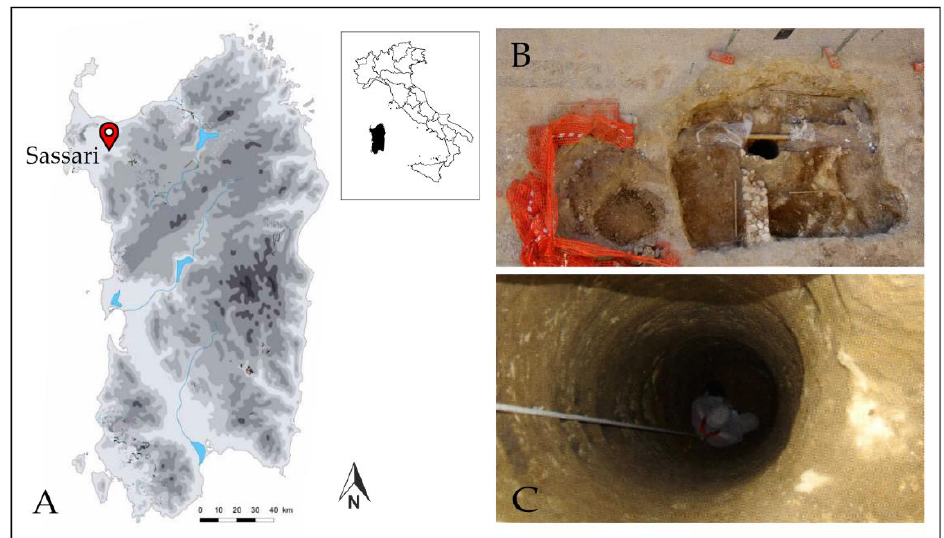
Figure 1. ( A ) Location of the city of Sassari; ( B ) The archaeological excavation area of Via Satta (Sassari, NW Sardinia); ( C ) The Middle Ages well (Biccone 2013, modified).